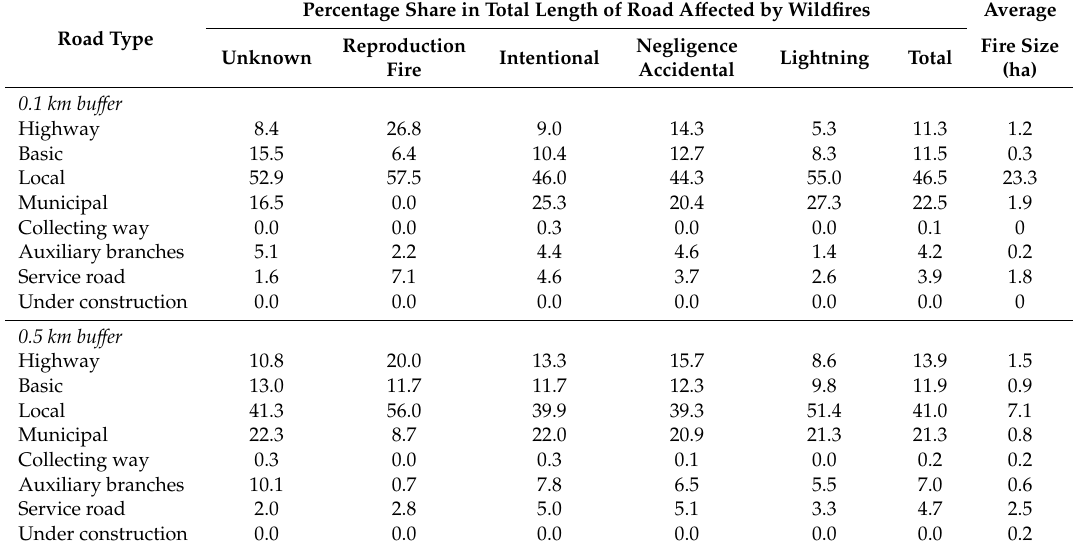
Table 1. Road length (per cent share in total network length) by type, within a buffer of 0.1 and 0.5 km from the origin of the fire (i.e., ignition point) by type of cause.